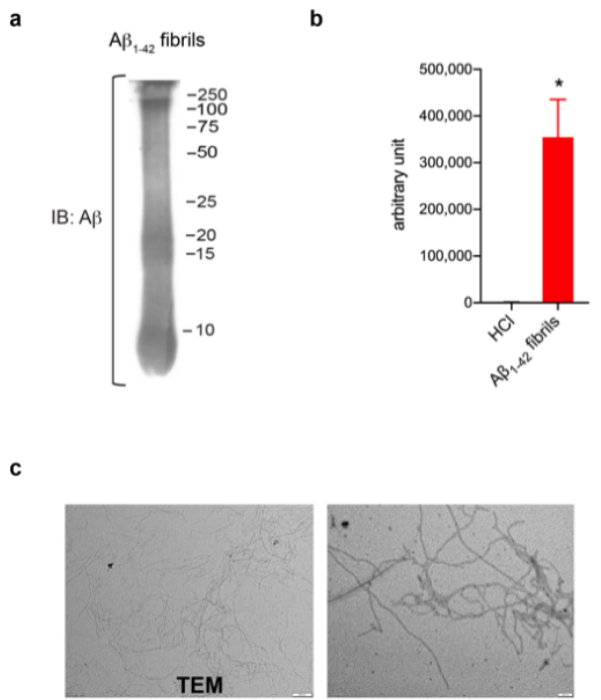
Figure 1. A β 1-42 fibril generation and validation. ( a ) Immunoblotting detecting A β 1-42 fibrils using anti- β amyloid clone 6E10 antibody. ( b ) ThioT assay shows a greater amount of fluorescent signal in fibril-enriched preparation compared to control solvent DMSO-HCl. Data are representative of three independent preparations and are expressed as mean ± SEM. Data were analyzed using unpaired t -test, * p = 0.0120. ( c ) TEM performed on A β 1-42 preparation reveals thread-like fibril structure. Scale bar 500 nm and 200